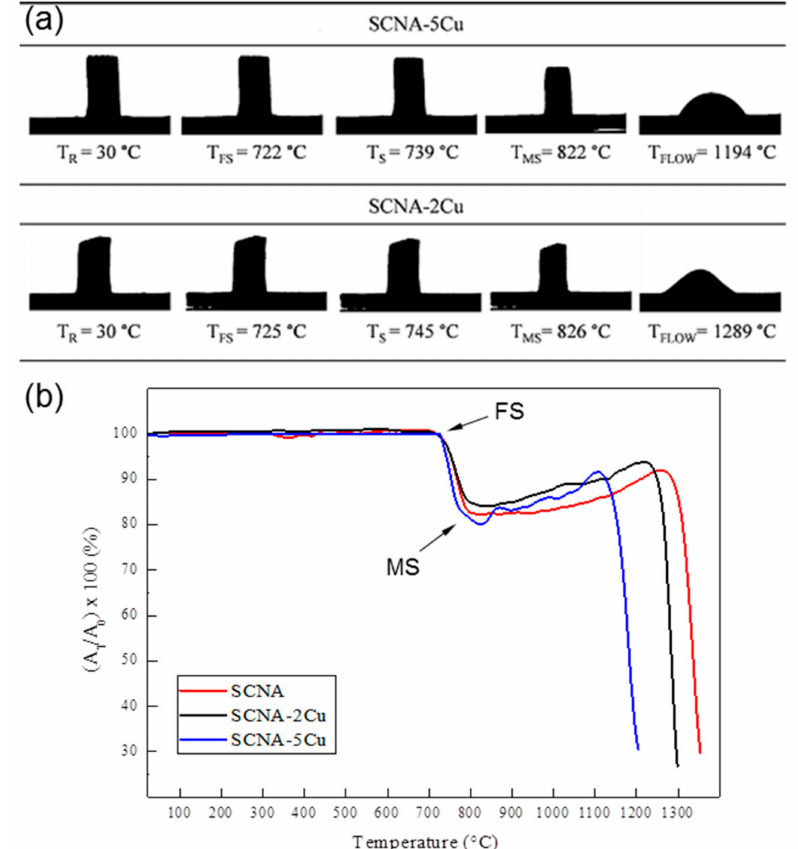
Figure 1. Results of HSM: ( a ) silhouettes of the Cu-doped SCNA-based glasses sample at different characteristic temperatures upon heating (T R room temperature, T FS first shrinkage, T S softening, T MS maximum shrinkage, T FLOW flowing); ( b ) shrinkage variation as a function of temperature (A 0 area of the silhouette at room temperature, A T sample area at the current temperature).